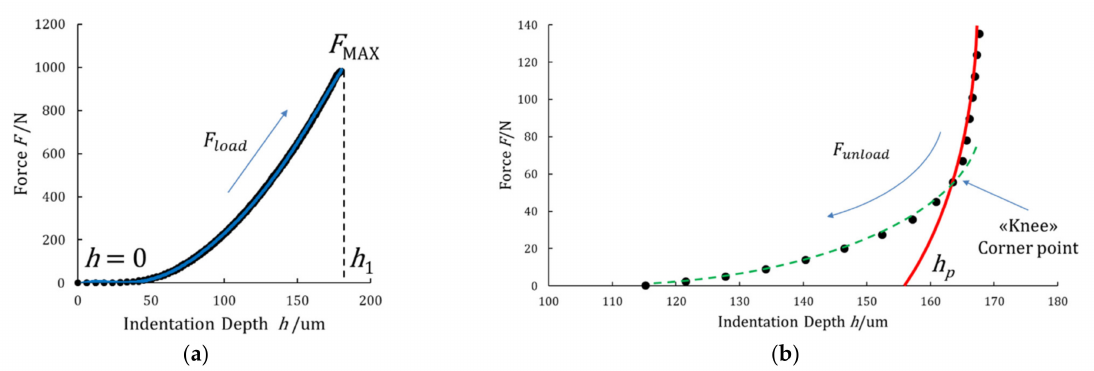
Figure 11. ( a ) Loading curve obtained by Equation (12); ( b ) best fit (red) of the unloading curve obtained by Equation (13) and the identification of the expected permanent indentation depth h p from the zero value of the fitting curve.